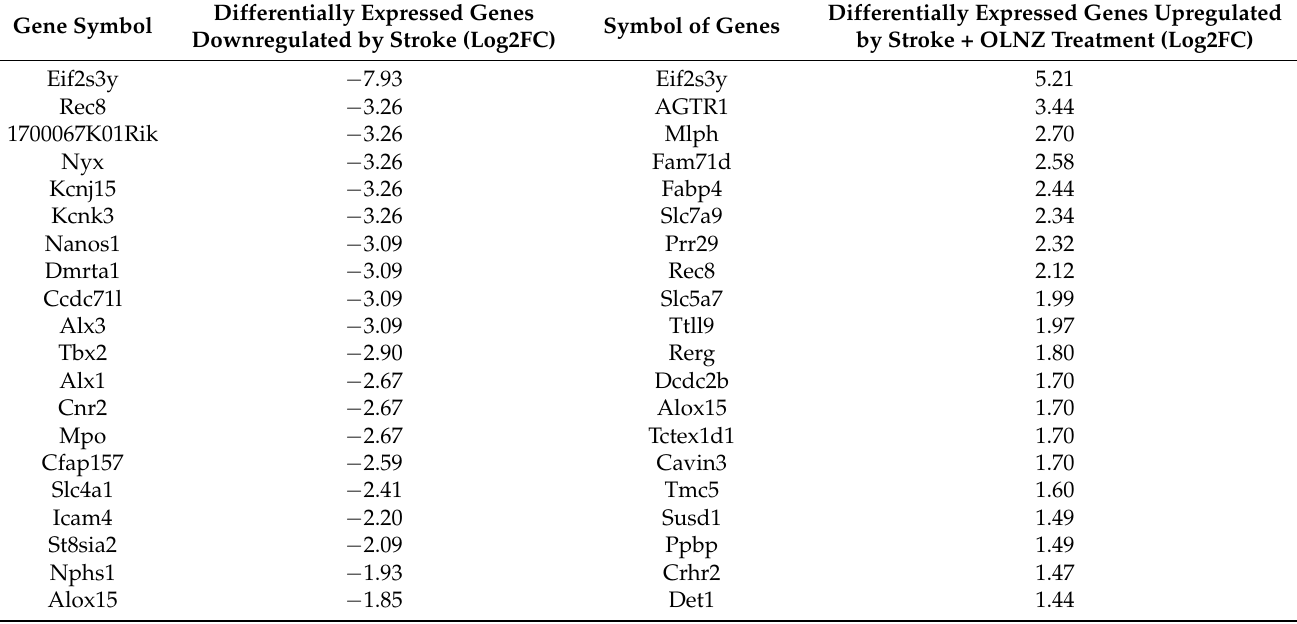
Table 3. List of the few most downregulated protein-coding genes in the transient-ischemia (TI)- induced stroke model in gerbils, and the few most upregulated protein-coding genes in the TI-induced stroke + olanzapine treatment